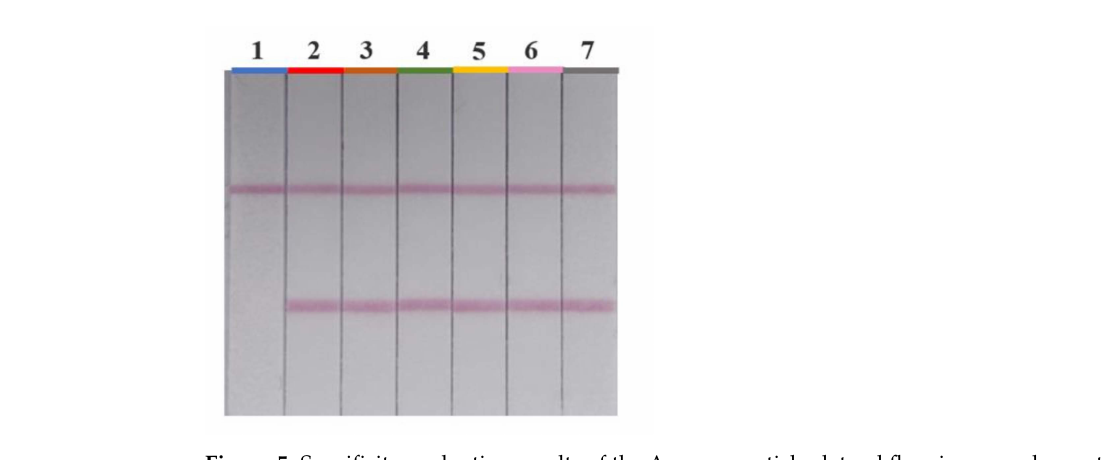
Figure 5. Specificity evaluation results of the Au nanoparticles lateral flow immunochromatography (AuNPs-LFIA): 1, furosemide; 2, hydrochlorothiazide; 3, metolazone; 4, bumetanide; 5, acetazolamide; 6, torasemide; 7, ethacrynic acid.